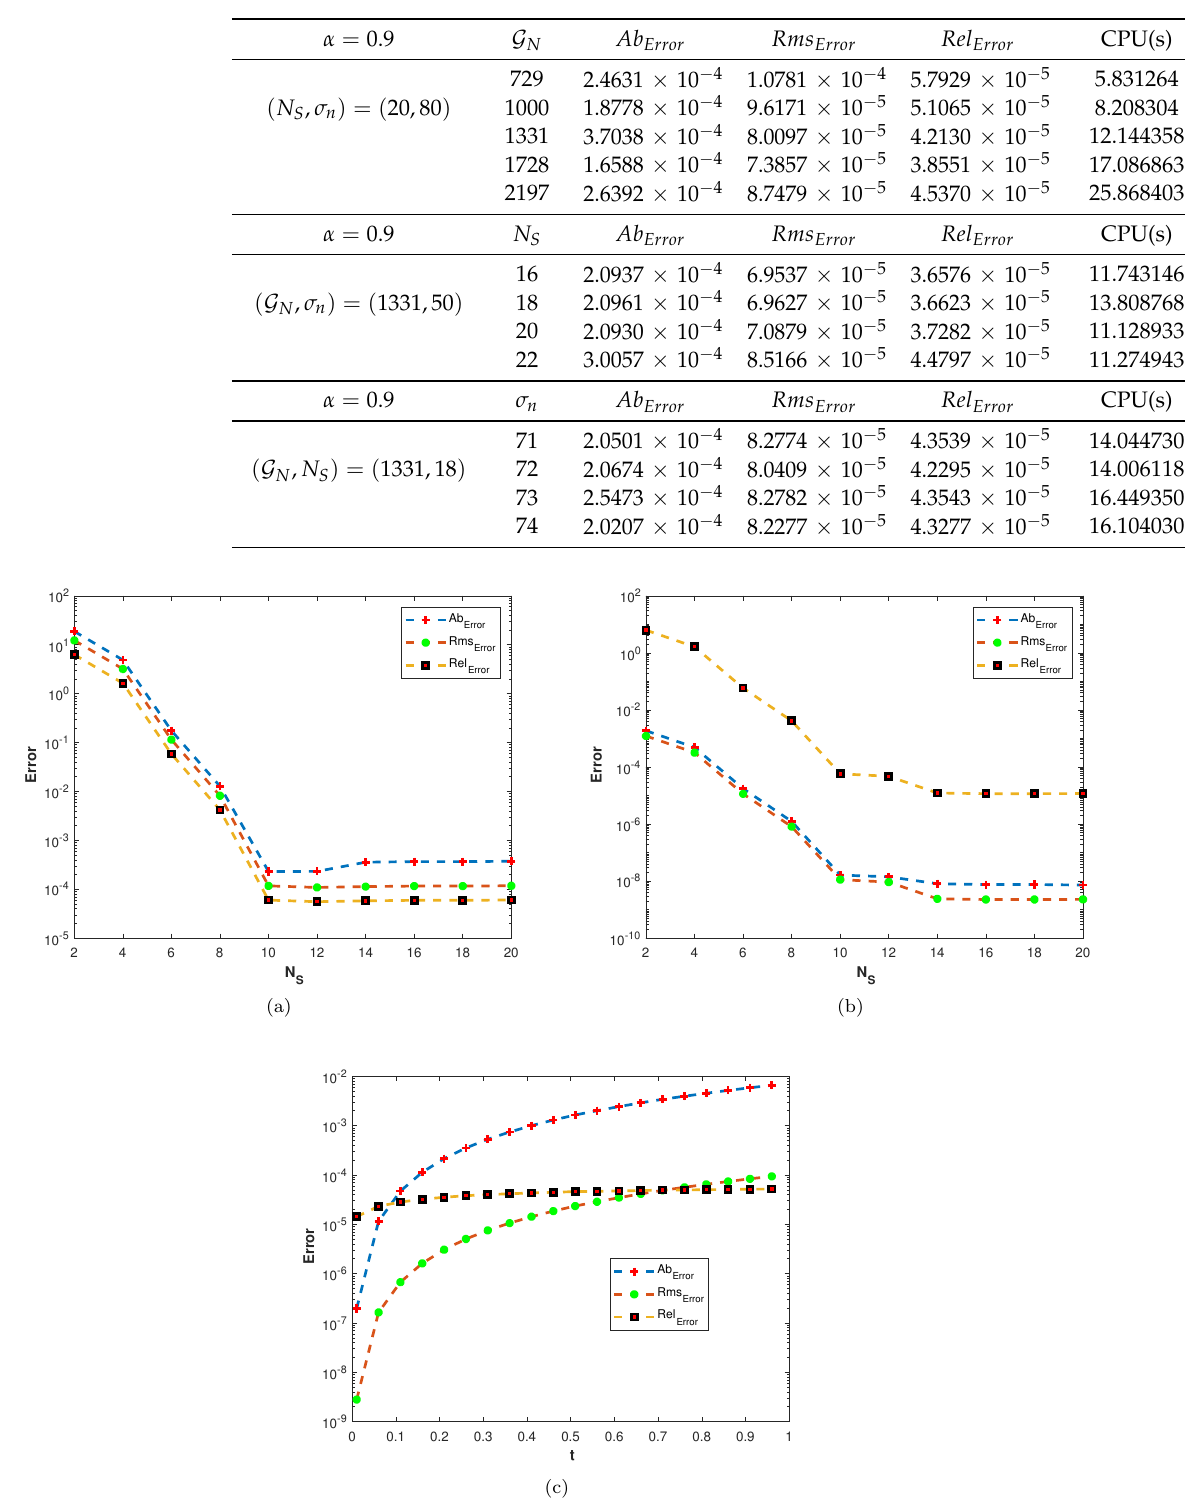
Figure 18: (a) Plots of Plots of Ab Error , Rms Error , and Rel Error versus N S with Figure 18. ( a ) Plots of Plots of Ab Error , Rms Error , and Rel Error versus N S with (b) (a) Plots of Plots of Ab Error , Rms Error , and Rel Error versus N S with at T = 1. ( b ) Plots of Plots of Ab Error , Rms Error , and Rel Error versus N S with (c) Plots of Plots of Ab Error , Rms Error , and Rel Error versus t with at T = 0.01. ( c ) Plots of Plots of Ab Error , Rms Error , and Rel Error versus t with alpha = 0.9, N S =